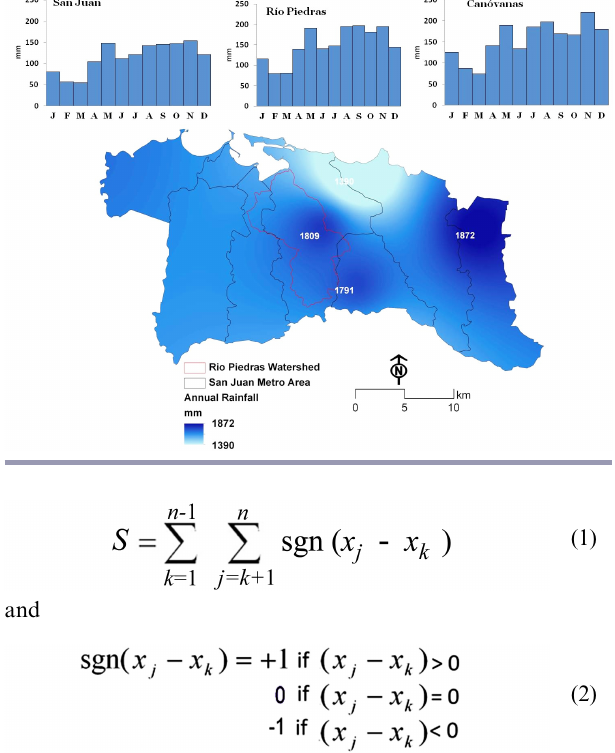
Fig. 2 . Average annual rainfall distribution in San Juan metropolitan